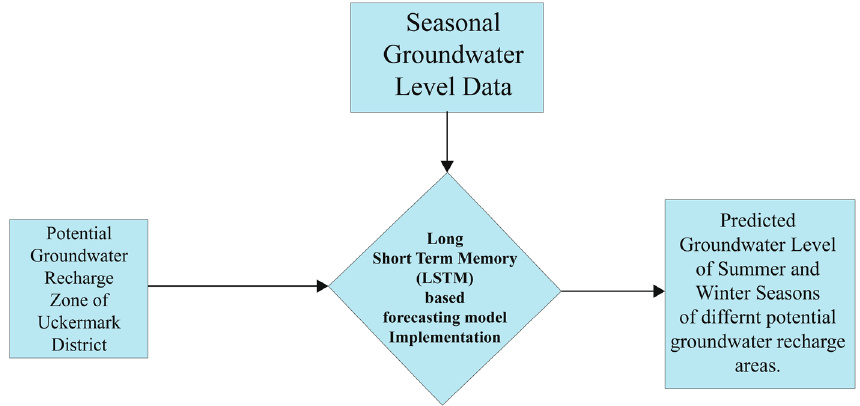
Figure 2. Workflow for seasonal groundwater level